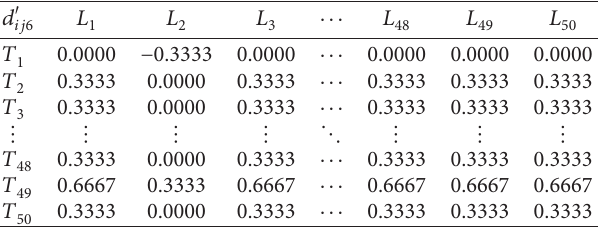
Table 29: Normative profit and loss matrix D tenants’ housing decoration degree.